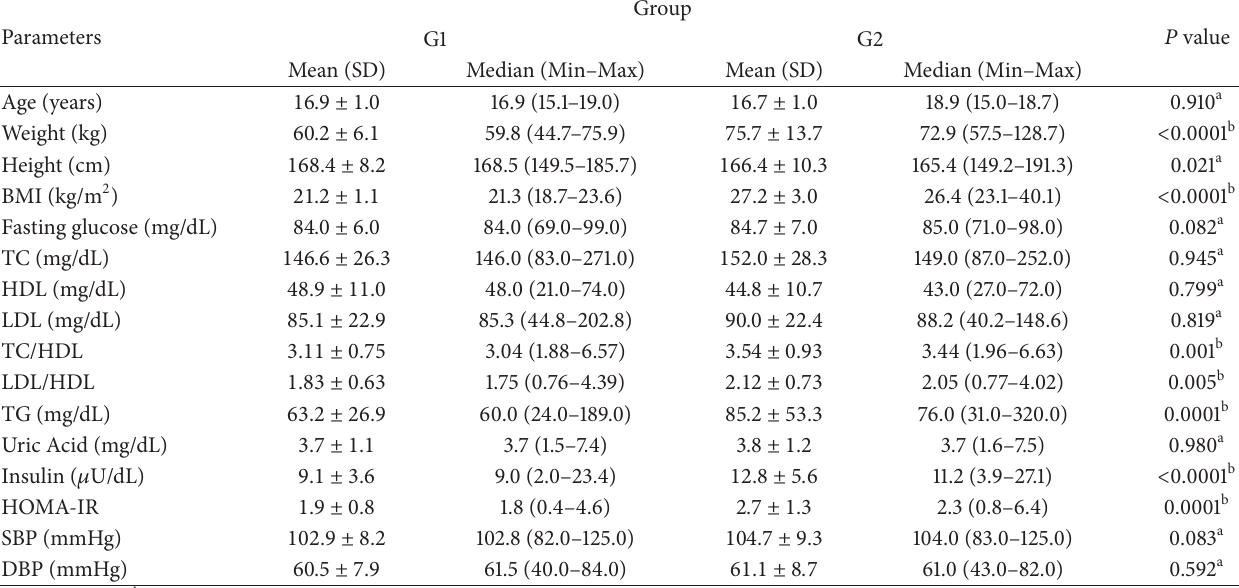
Table 2: Physical and metabolic characteristics of the adolescents according to studied group (Vic¸osa, Minas Gerais, Brazil (2010)).